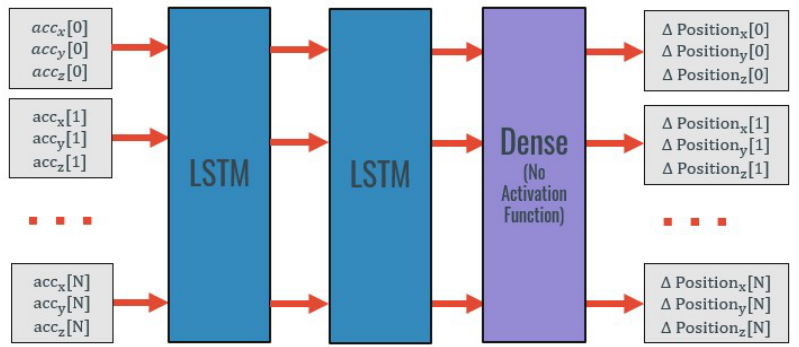
Figure 6. Neural network architecture with no type of warm start for three-axis displacement estimate.